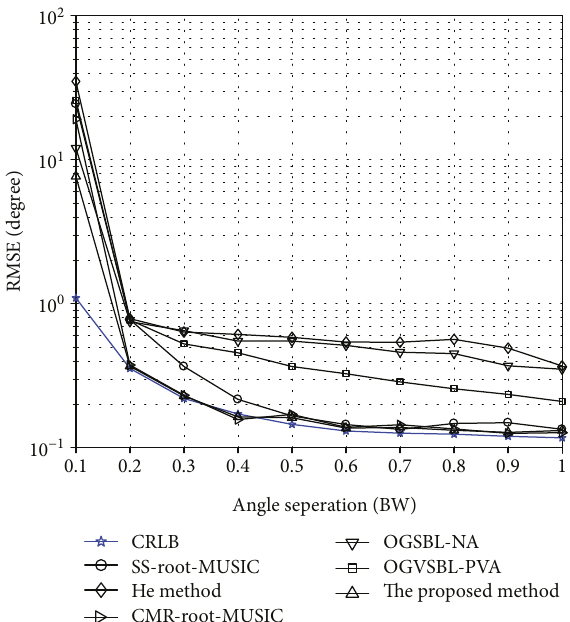
Figure 5: RMSEs of DoA estimation versus angle separation for M = 6 , N = 500 , and SNR = 0dB